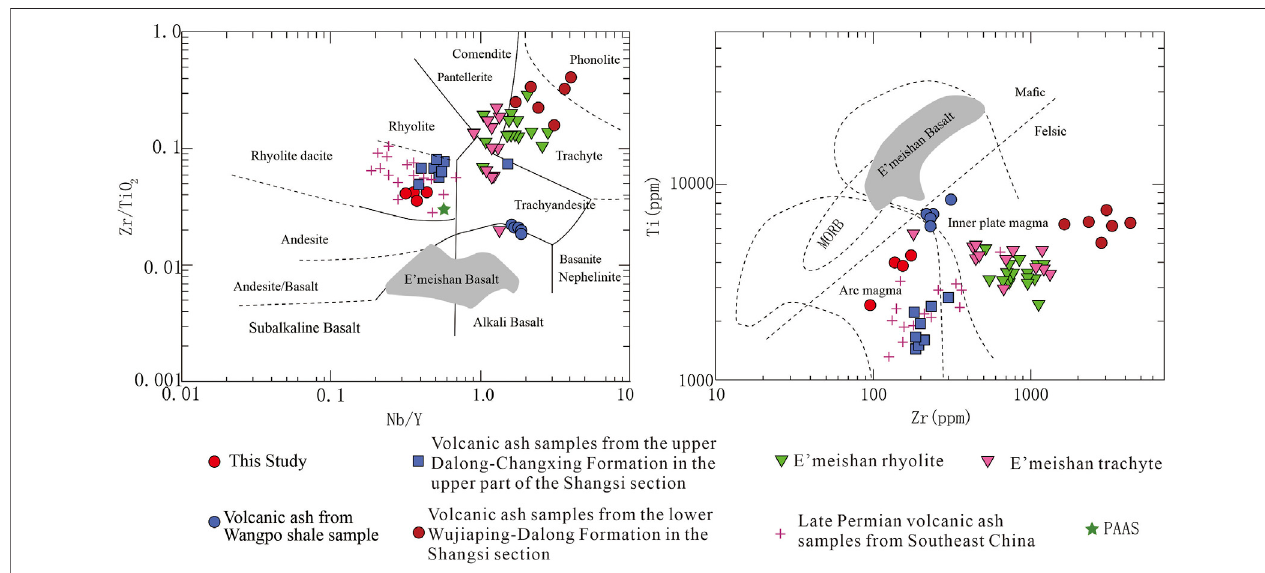
FIGURE 7 | Nb/Y-Zr/TiO 2 (Winchester and Floyd, 1977) and Zr-Ti (Pearce, 1982) crossplots for volcanic ash samples from the Lengshuixi section in the Maokou Formation [reproduced from Huang et al. (2018)]. Wangpo-shale volcanic ash data was taken from (Pearce, 1982); the data of the volcanic ash from the Wujiaping- Changxing Formations in the Shangsi section was taken from Huang et al. (2018); the data of rhyolites and trachytes from the Emei Mountain were taken from Xu et al. (2001),Fanetal.(2008),Heetal.(2010),Qietal.(2008),Xiaoetal.(2003),Xiaoetal.(2004);thedataofthelast-phasevolcanicashfromtheUpperPermianSeriesin southeast China was obtained from Liao et al. (2016a), Liao et al. (2016b); post-Archean Australian shale data was taken from McLennan (2018).